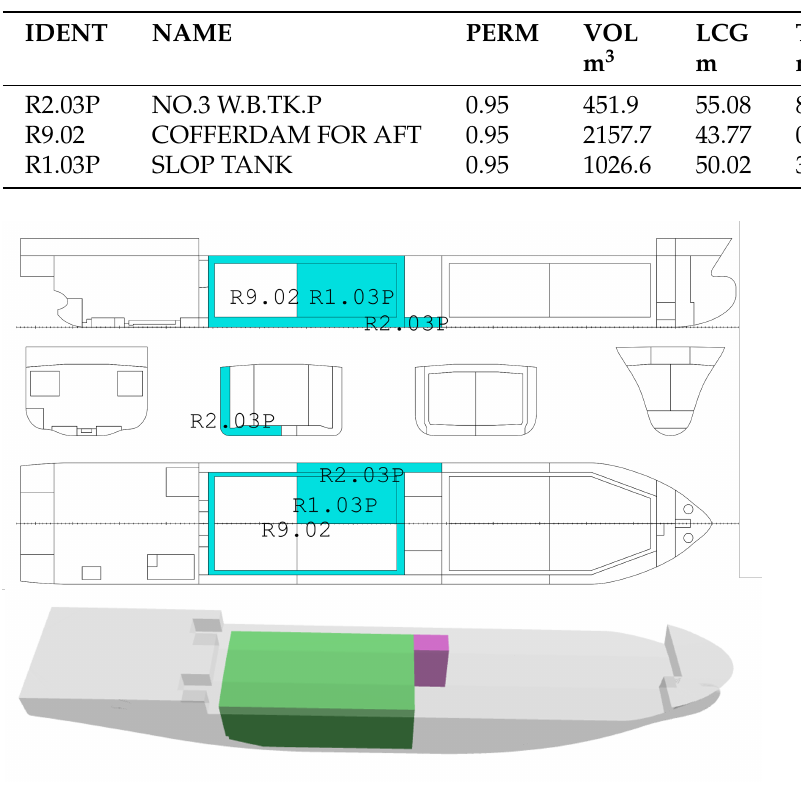
Figure 10. Illustration of damage case DAM10.